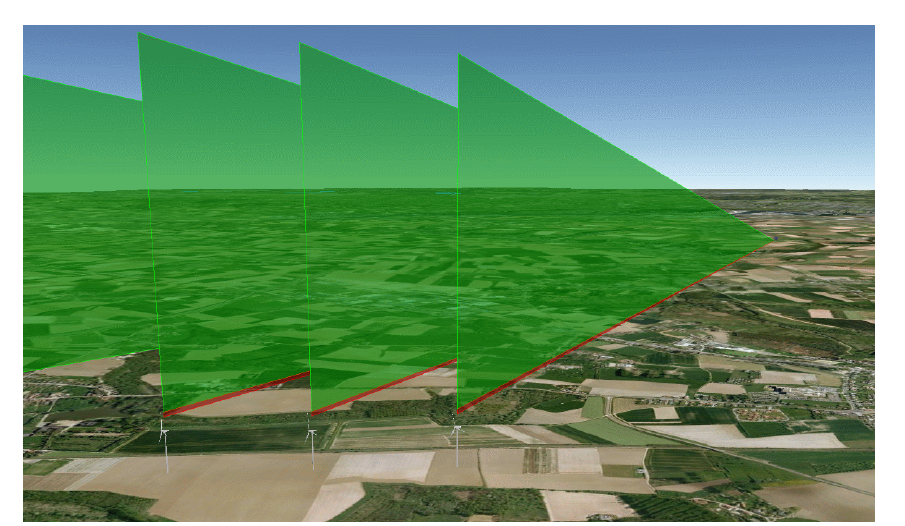
Figure 1. Results of an impact analysis on a radar. The figure shows the beam of a scanning radar (green) and the part of the beam that is affected by the wind turbines (red)